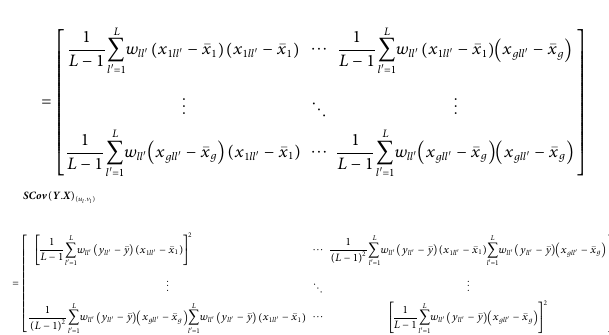
Using the weighted shrunken covariance matrices, the most signi fi cant linear combination at location ( u l , v l ) can be determined as the maximum Eigenvector of SCov ( Y,X ) ( u